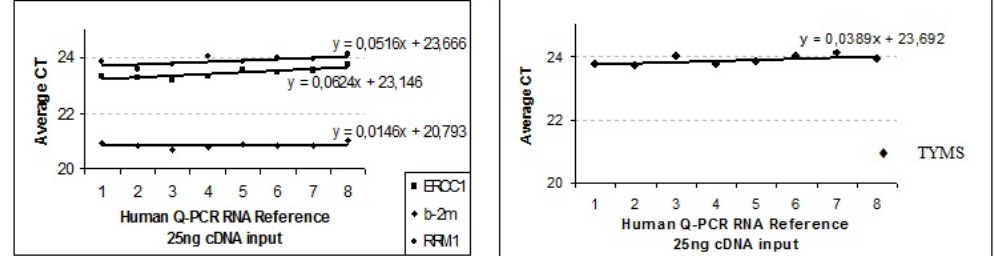
Figure 10. Determination of intra-assay variation in 25ng reverse transcribed total RNA.